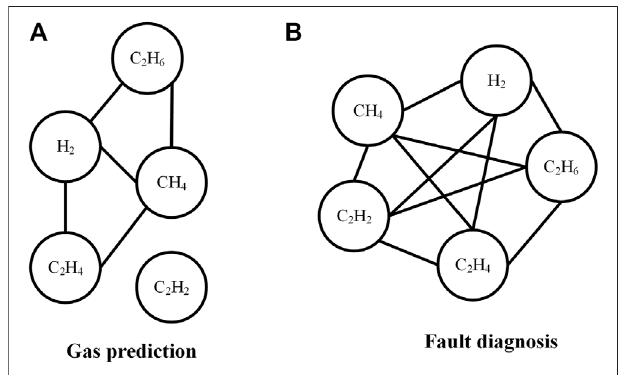
FIGURE 2 | Relationship diagram of characteristic